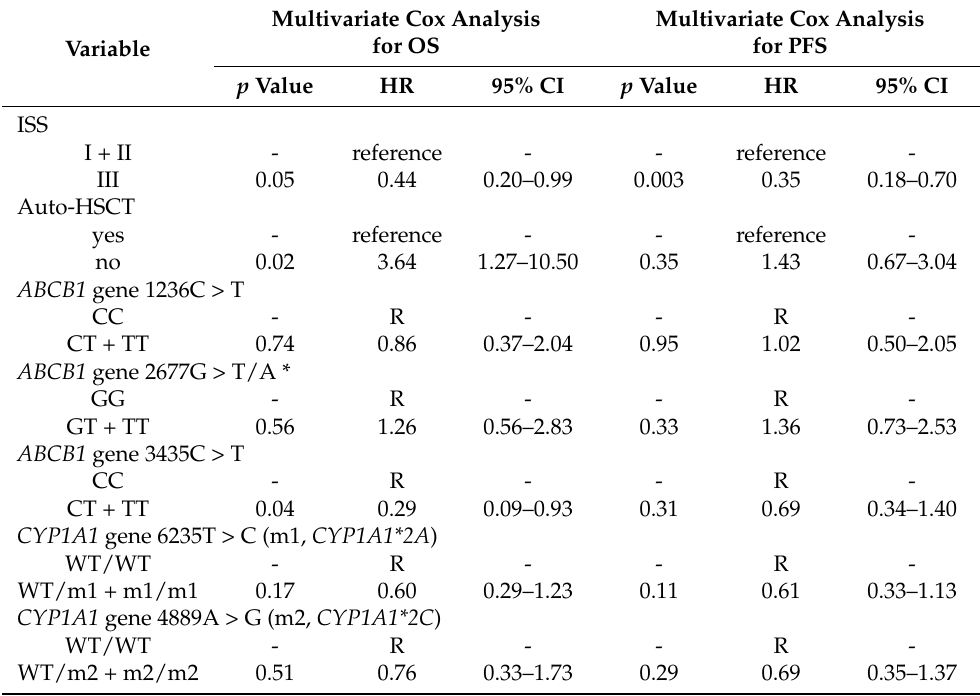
Table 5. Multivariate Cox analysis in survival of MM